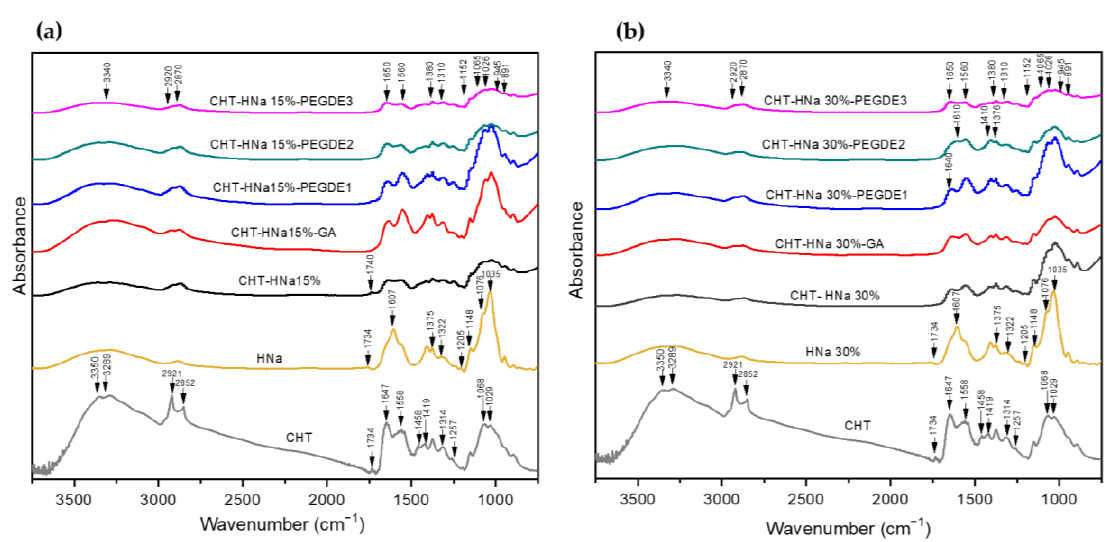
Figure 1. FTIR spectra of PEGDE crosslinked CHT films. HNa 15% ( a ) and HNa 30% ( b ).